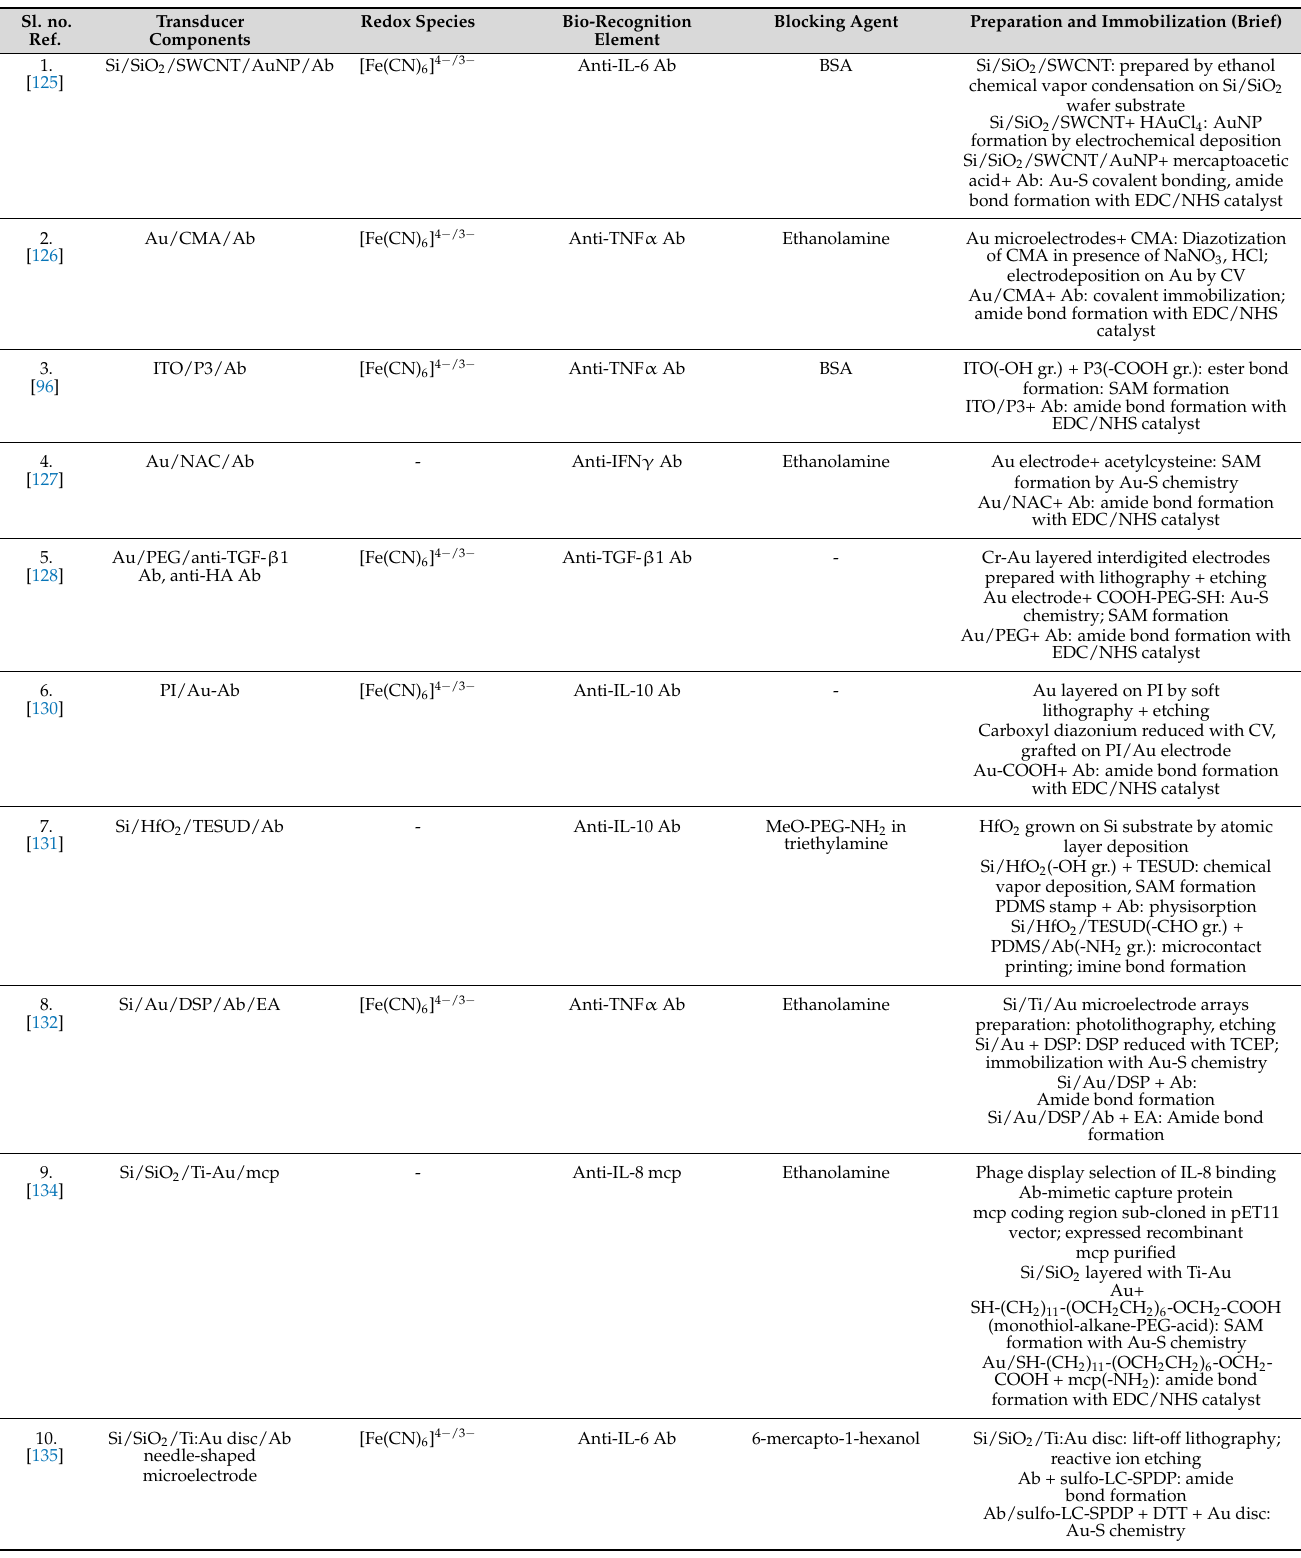
Table 5. SAM-enabled impedimetric immunosensors: Design and sensor preparation. Sl. no.